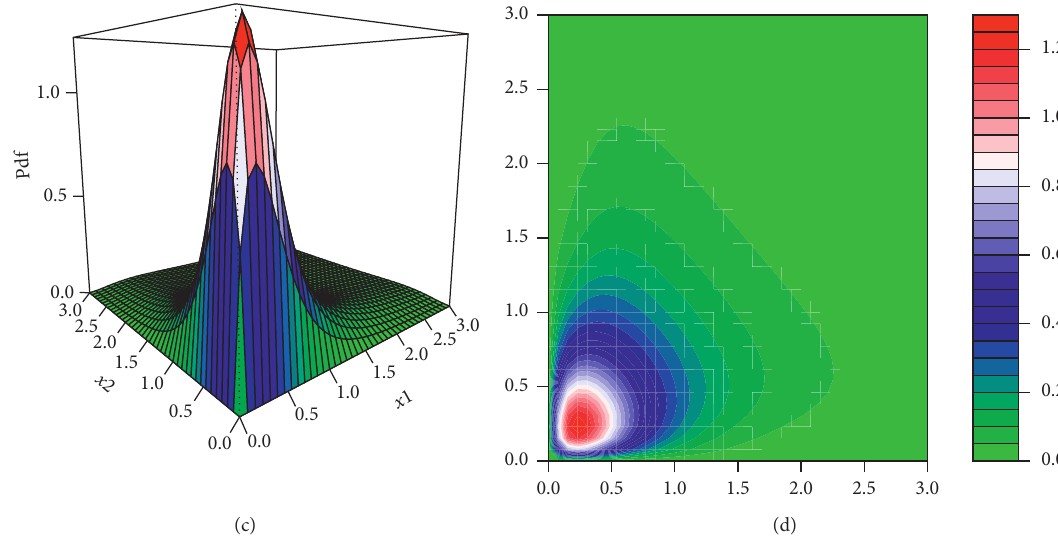
Figure 4: Different plots for the pdf of the FGMBL-Claim distribution for α